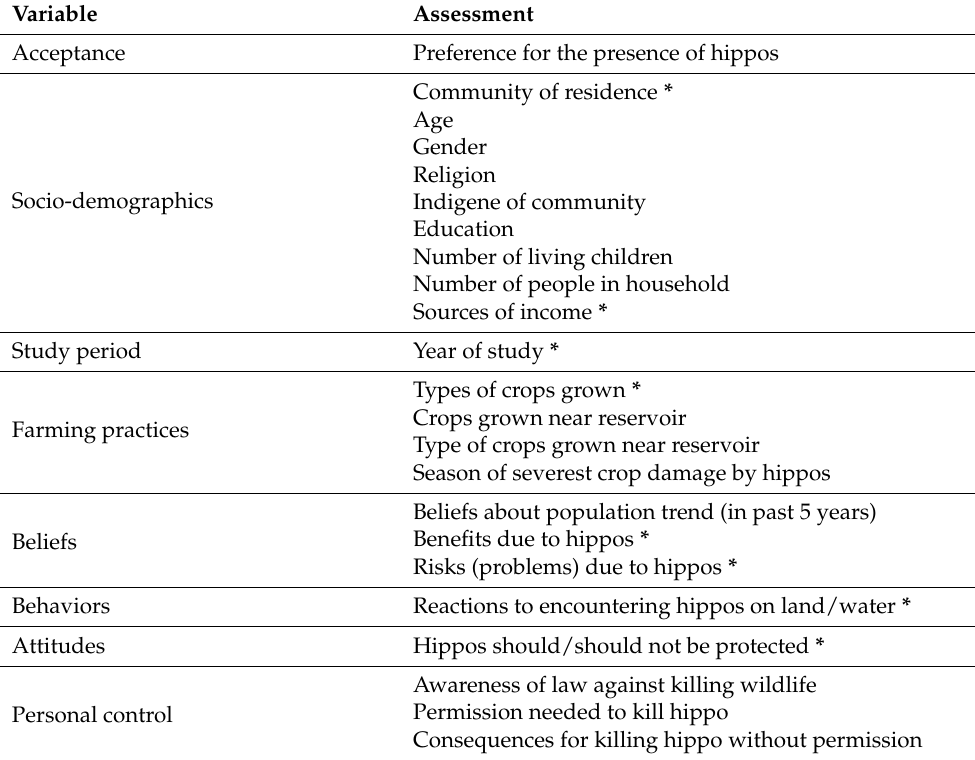
Table 3. Variables used to evaluate human-hippo relations at Kiri Dam reservoir, Adamawa State, Nigeria. Variables included in the multivariate analysis are starred ( *